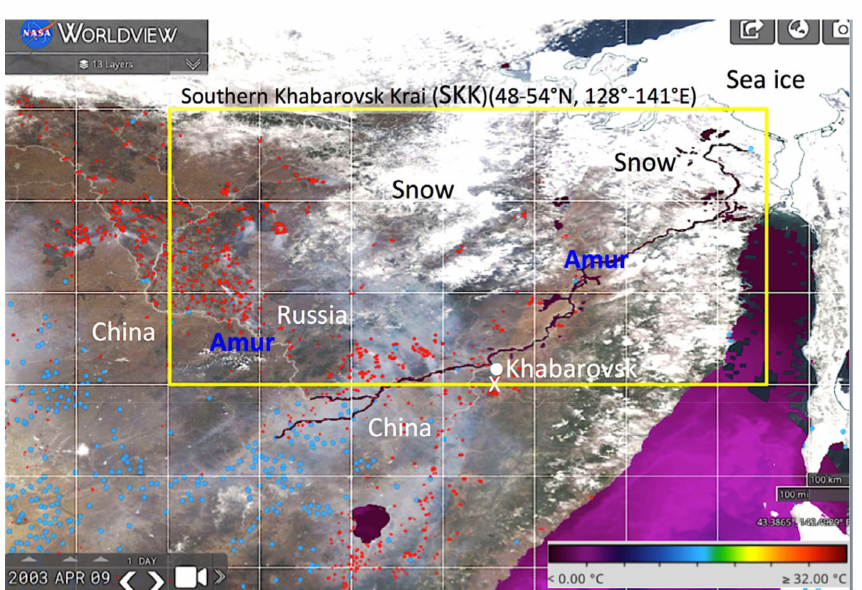
Figure 6. Satellite image (corrected reflectance (true color), MODIS on Terra, Sea Surface Temperature (L4, MUR), red dots; hotspots, blue dots; settlements) on April 9, 2003 (one day during (4)10Apr (cid:48) 03) [28]. The weather charts at the lower-level (925 hPa) in March-, April-, and May-Fire are shown in Figure 7. In Figure 7, ‘X’ indicates the wind reference site (48N, 135E). Movements of low-pressure systems are shown by lines with arrows. The height of a low-pressure system is shown by ‘L’ and its height (e.g., ‘L630’), and the SKK study region is indicated by a rectangle.